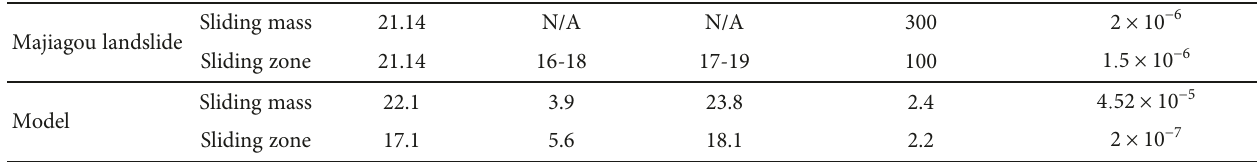
Table 2: Material parameters of the Majiagou landslide and